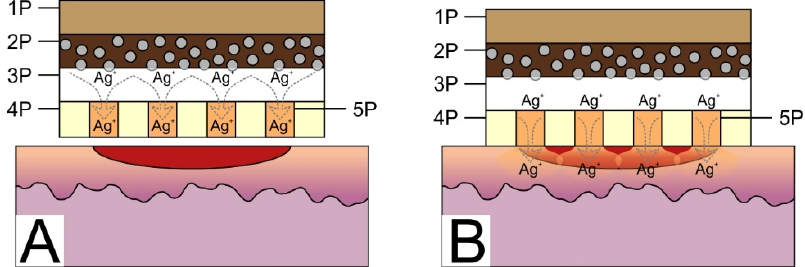
Figure 7. The working principle of the patch prototype. ( A ) Initial Ag + accumulation in the agar/gelatin after application on DLC:Ag-coated silk sample (2P), the silver ions start to diffuse from silver NPs (indicated as grey circles in 2P) through the cellulose membrane (3P) into an agar/gelatin layer (5P) (SIAL). ( B ) When the bandage is applied on wounded skin the gelatin/agar (gel) in the SIAL layer warms up, the gel in silicone honeycomb structure (4P) melts and silver ions can diffuse towards the wound’s tissues (indicated as red half ellipse).